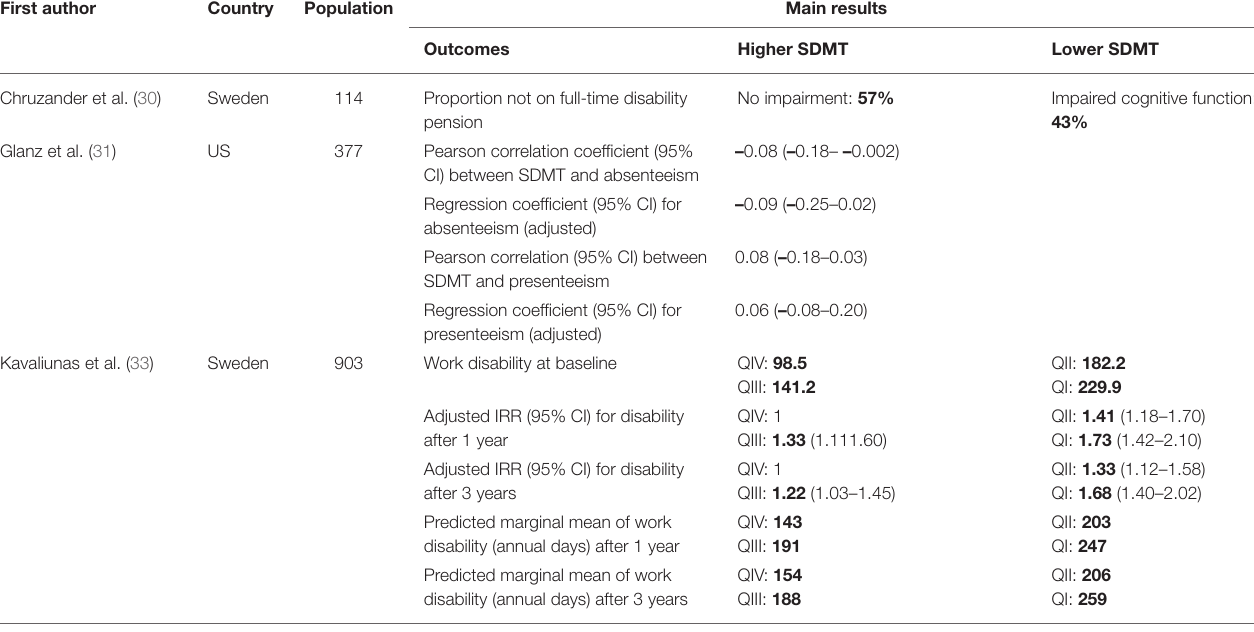
TABLE 7 | Studies that investigated work ability-related outcomes in patients with MS within different levels of cognitive function.